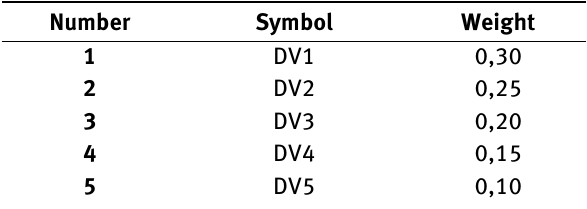
Table 1: Weights assigned to